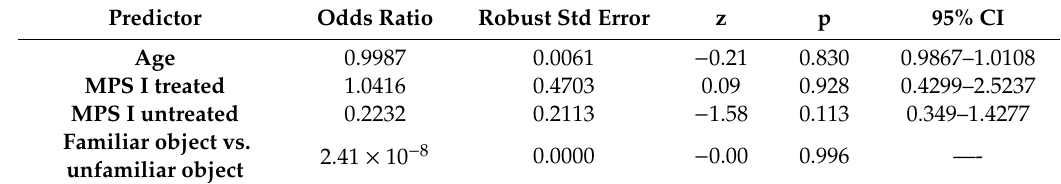
Table 16. Attention oddity mixed e ff ects logistic regression model. Analysis of MPS I a ff ected groups compared to normal group for choice (correct versus incorrect) at each session x trial and age.